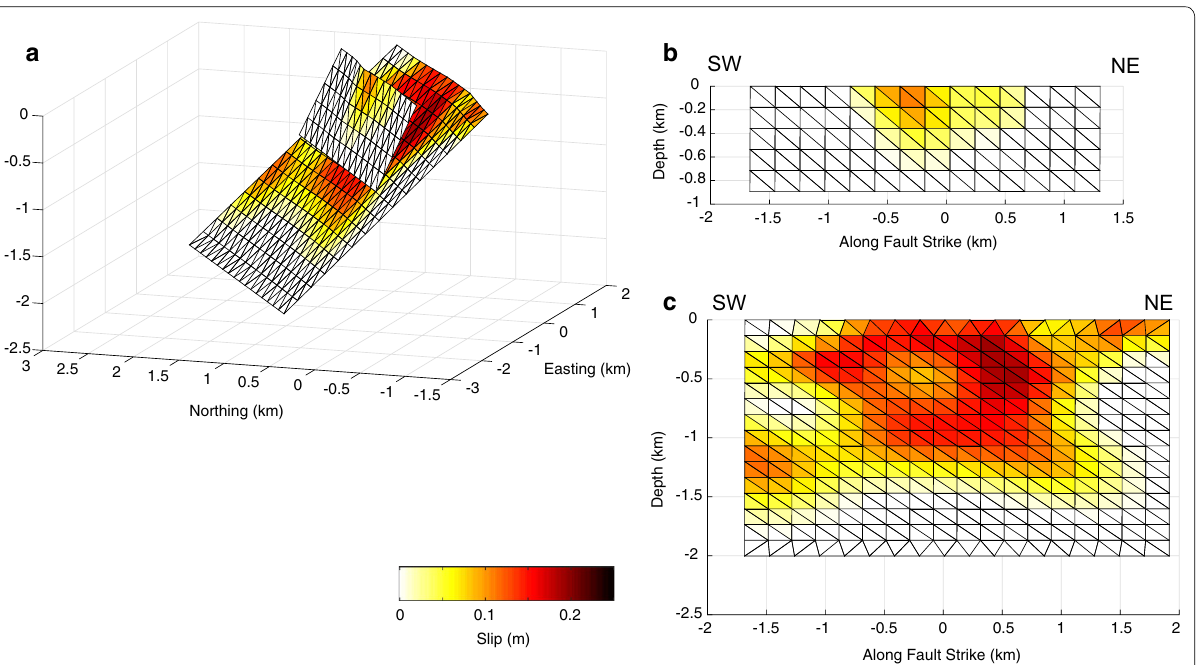
Fig. 8 Maximum likelihood fault model. a Perspective view. b Lateral view for the northern fault. c Lateral view for the southern fault